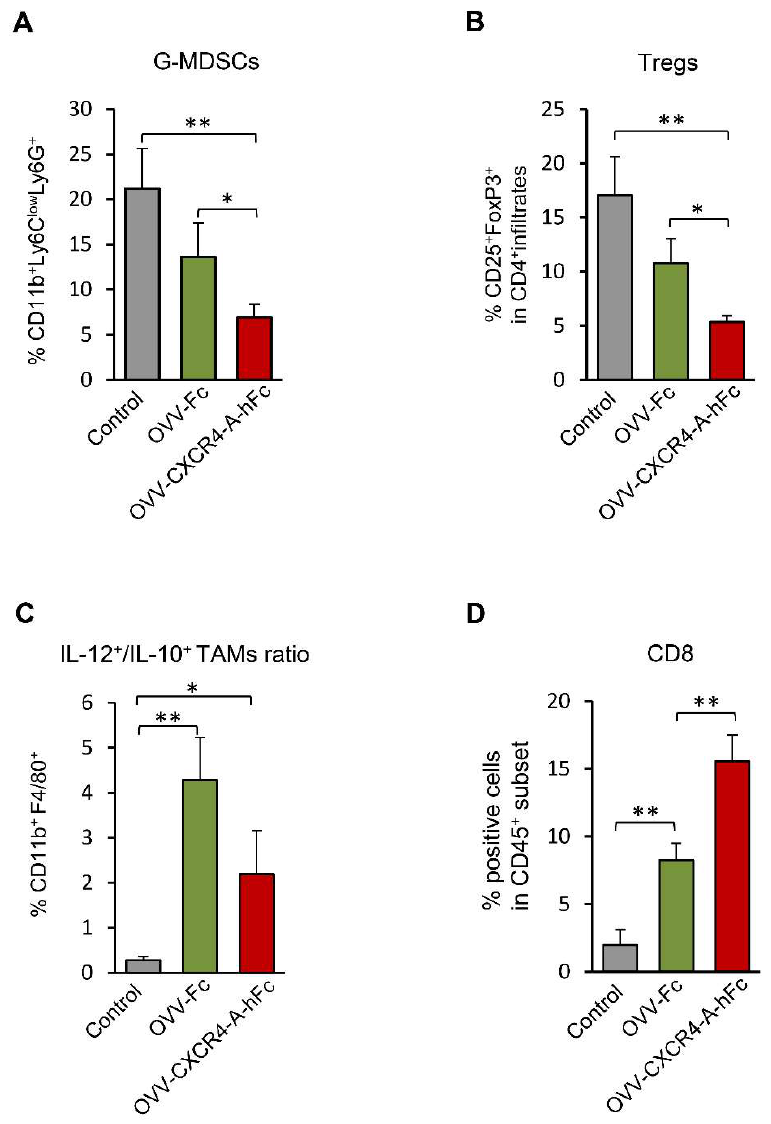
Figure 3. An armed OVV induces changes within the tumor microenvironment (TME) by targeting the CXCL12/CXCR4-signaling axis. The TME analysis performed on day 8 after completion of treatments. Frequencies of G-MDSCs (CD11b + Ly6C low Ly6G + ) ( A ), and Tregs (CD4 + CD25 + Foxp3 + ) ( B ),